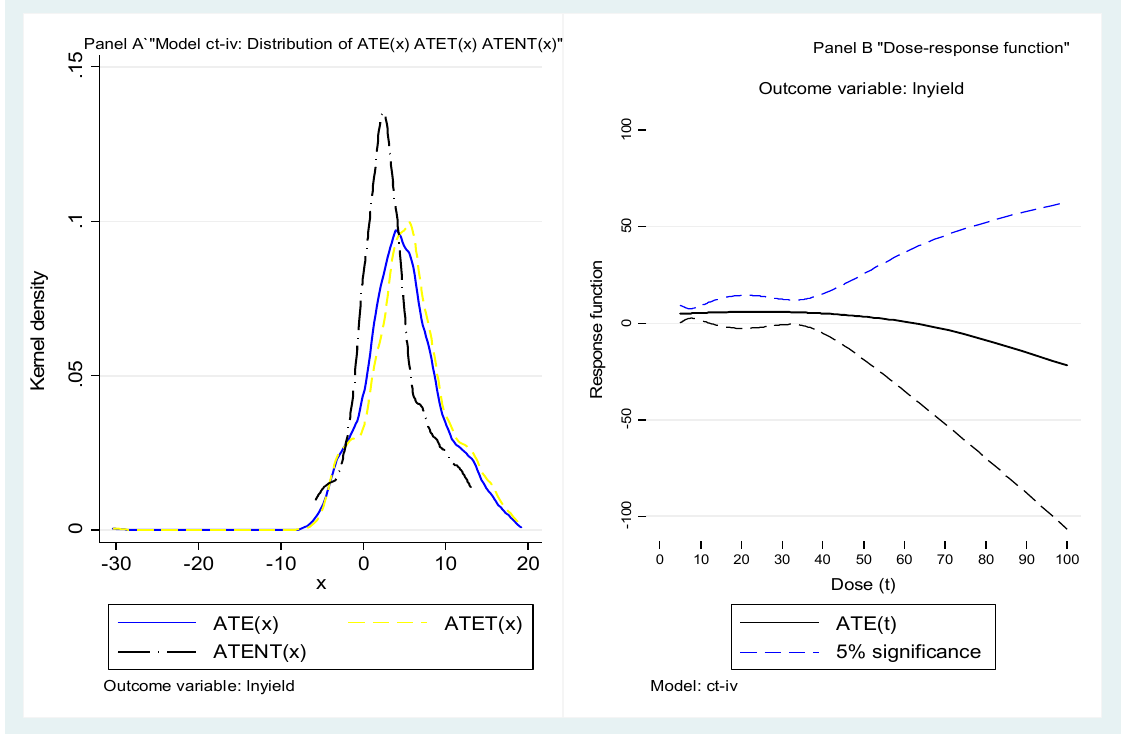
Figure 2. Distribution of ATE(x), ATET(x), and ATENT(x) and dose–response function for herbicides on rice yield.